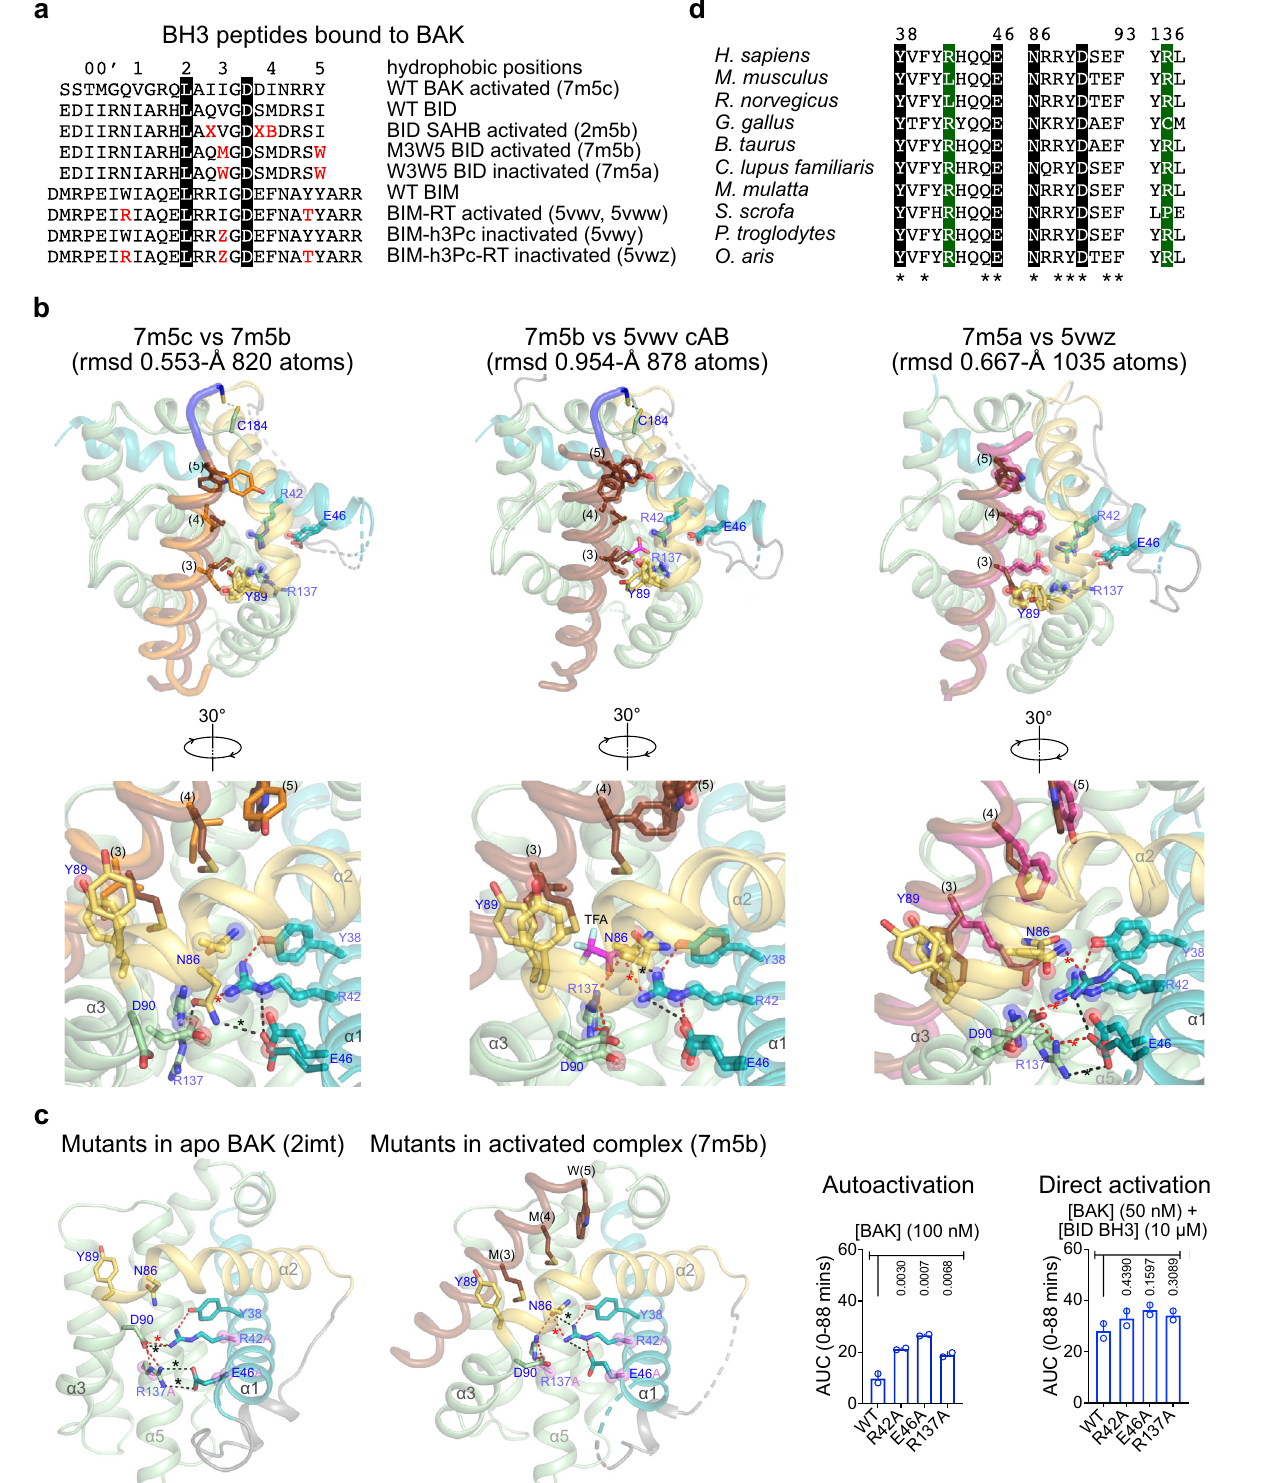
Effector activation 17,27,33 . To revisit this hypothesis considering the fi ve available crystal structures of activated BH3-bound BAK, we aligned BAK BH3-BAK with apo BAK and with BID and BIM BH3:BAK complexes. We found that all exhibit overall very similar structures and conformational changes induced by BH3 ligands relative to apo BAK (Fig. 6a, b and Supplementary Figs. 8, 9). The most dramatic changes induced by BH3 ligands NATURE COMMUNICATIONS| (2022) 13:250